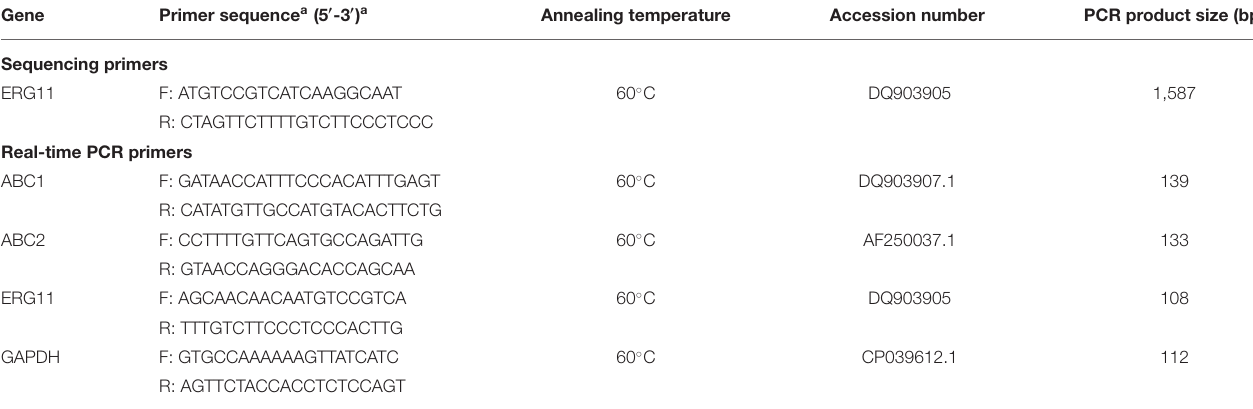
TABLE 2 | Primers used in this study.